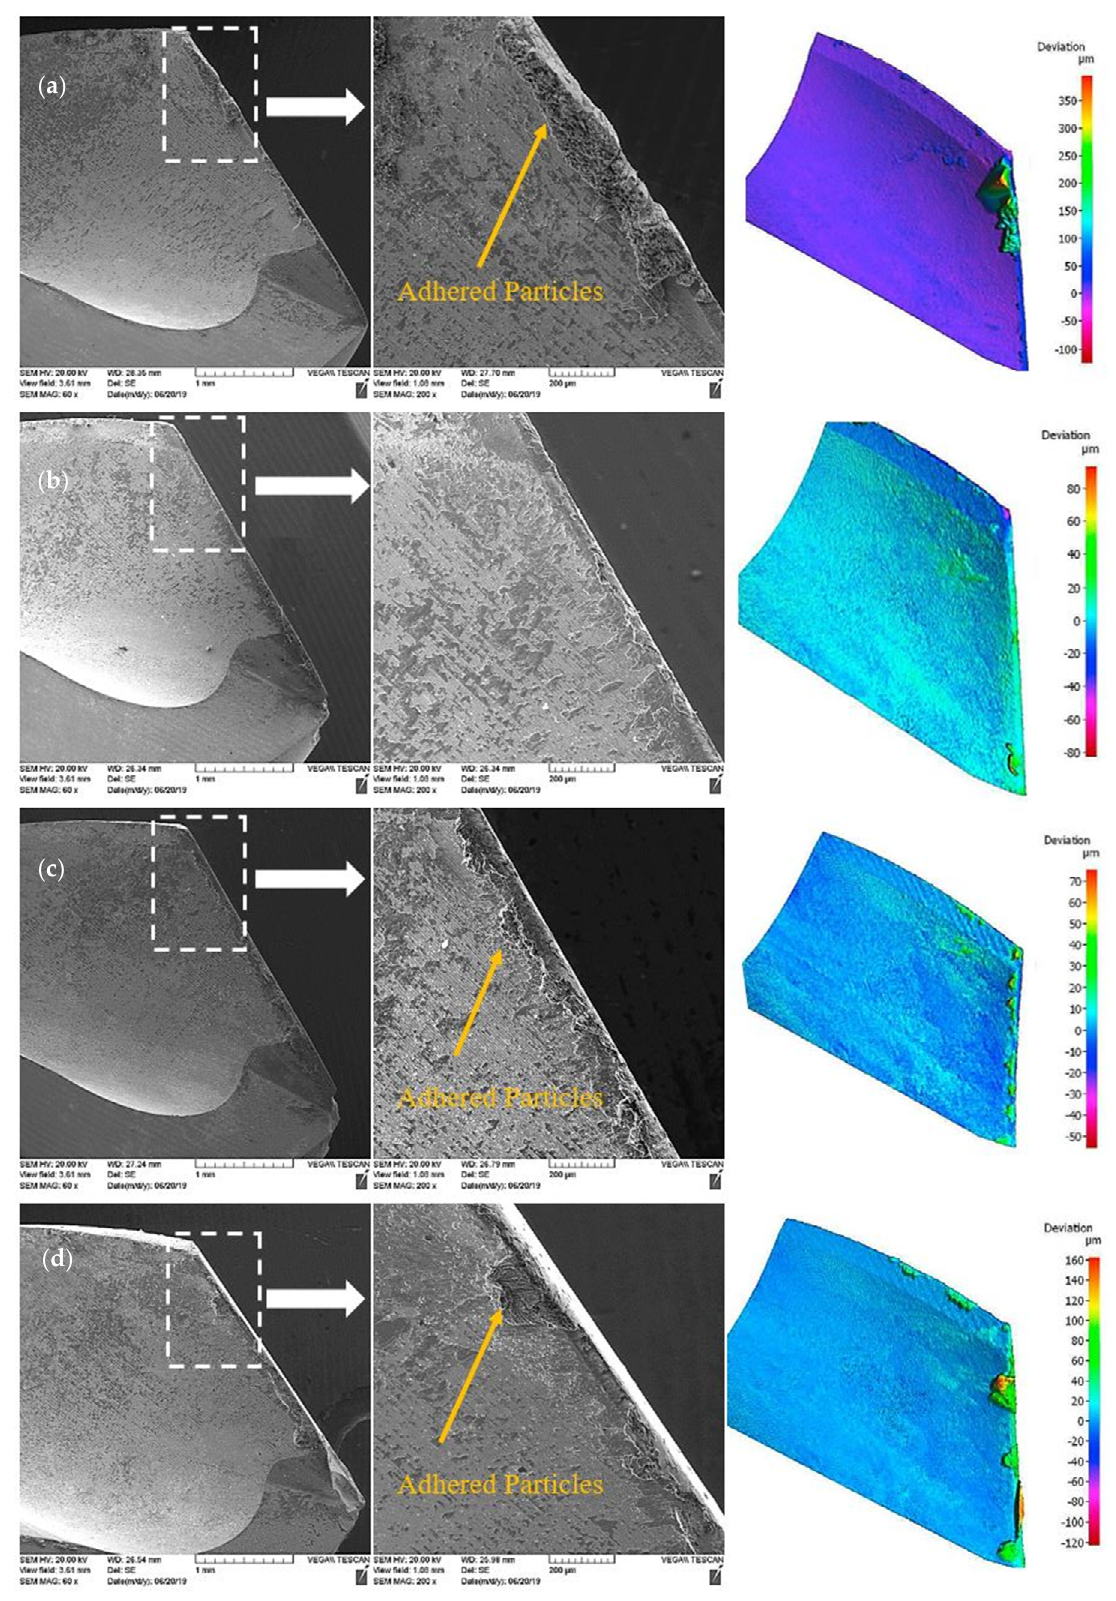
Figure 10. The SEM examination and surface topography analysis of the tool rake face at N = 2000 rpm for different vibration amplitude ( a ) conventional, ( b ) A m = 0.1 mm, ( c ) A m = 0.16 mm, and ( d ) A m = 0.25 mm.